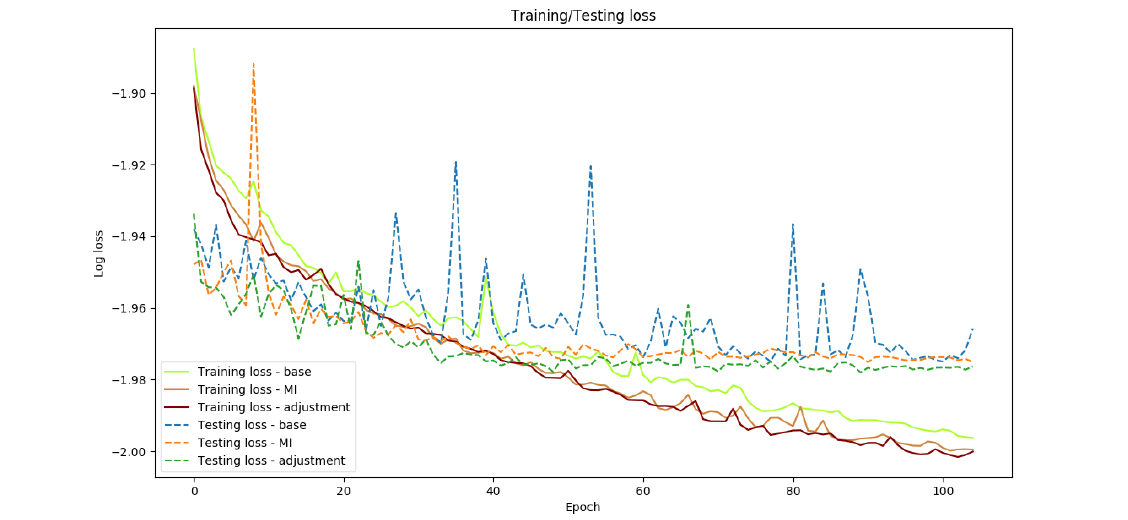
Figure 8. The training and testing loss on original data (base), MI-registered, and after Hough line patch adjustment. The registered data demonstrate more stable convergence than non-registered